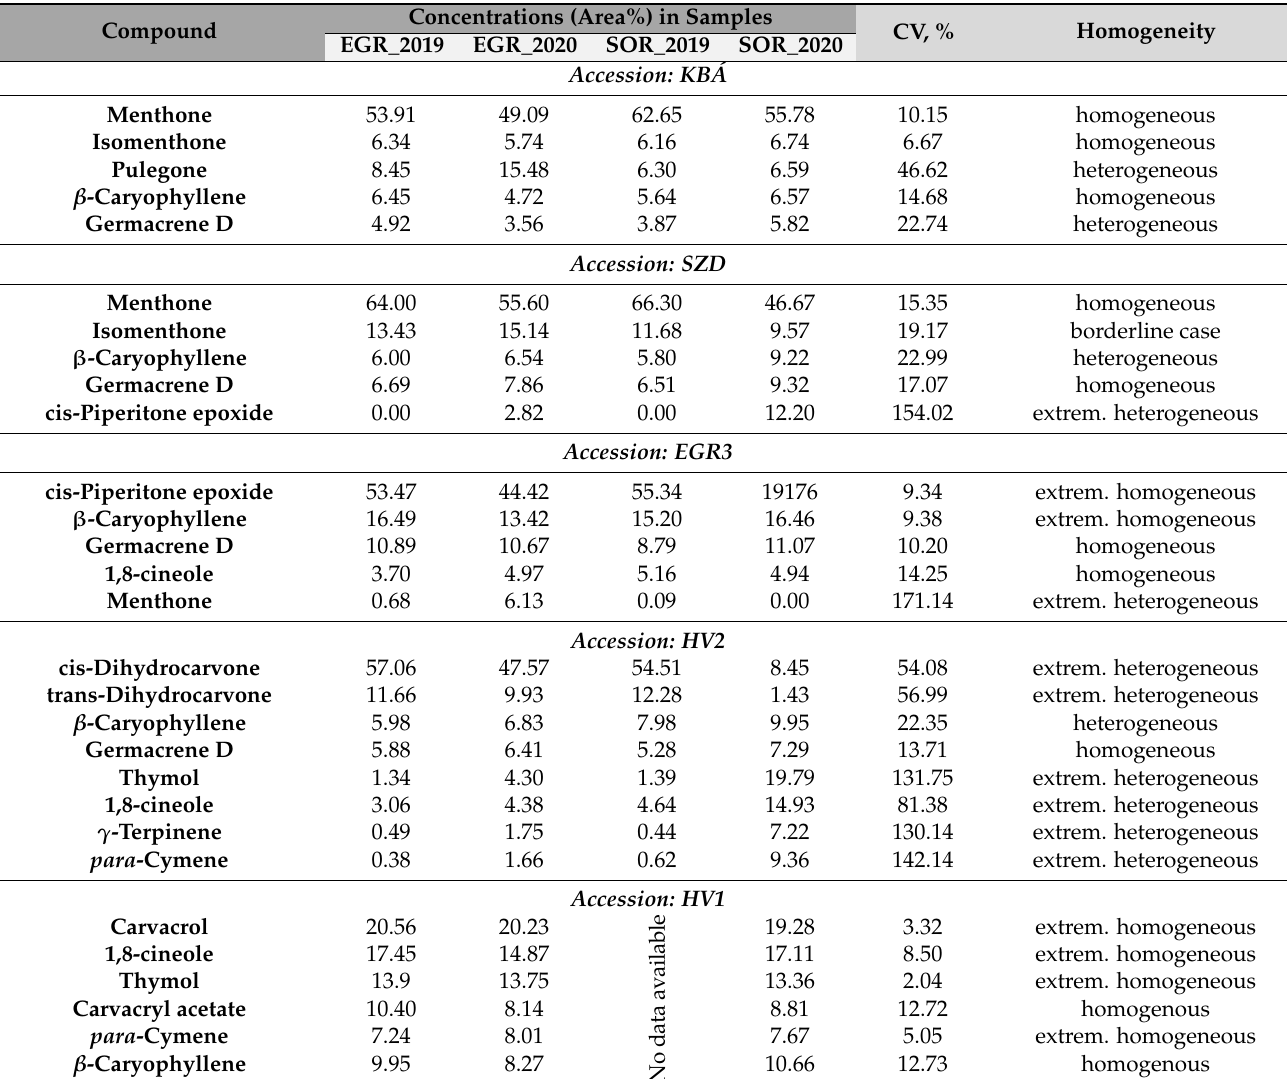
Table 4. Major components, their percentage, and its homogeneity in the investigated essential oils. The arrangement of the table is based on the